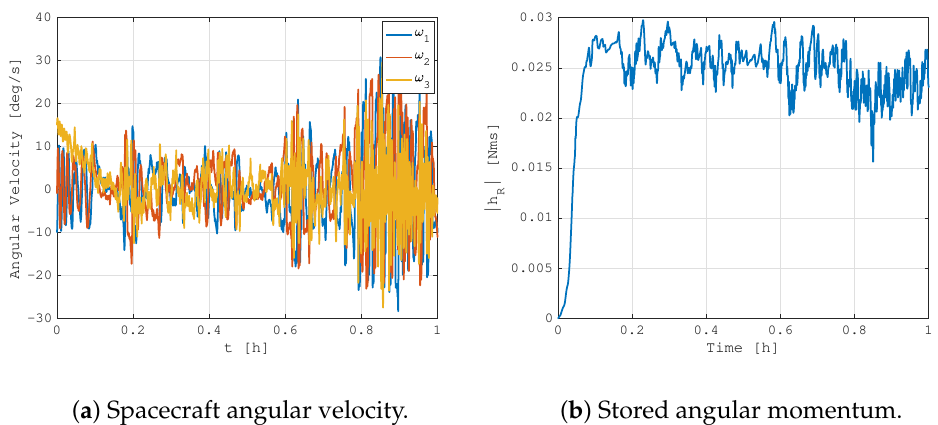
Figure 13. MIL simulation of velocity dumping control without integrated magnetic angular momen- tum